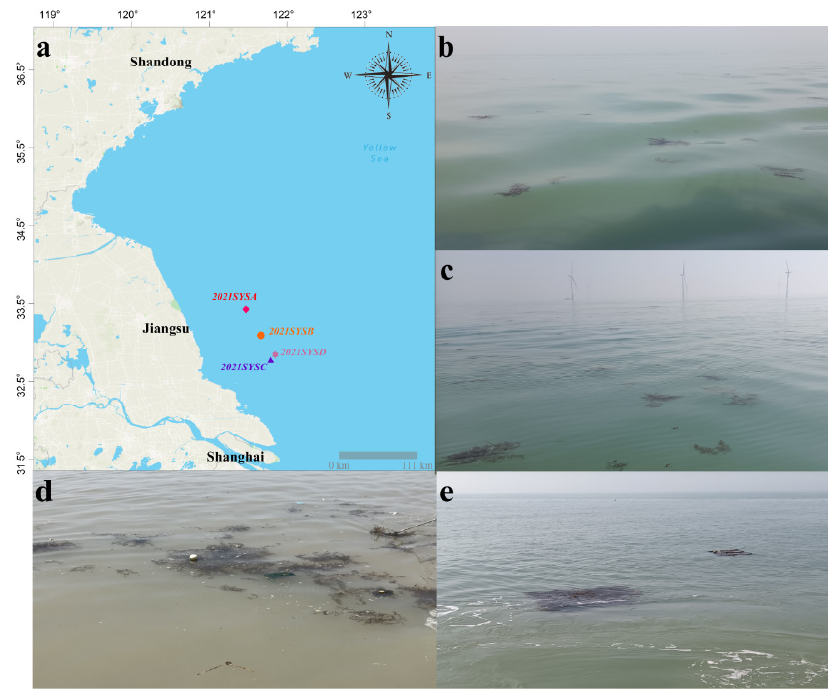
Figure 1. ( a ) Sampling sites of golden tide macroalgae in the Southern Yellow Sea; ( b – e ) Marine habitats of stations 2021SYSA, 2021SYSB, 2021SYSC, and 2021SYSD, respectively.